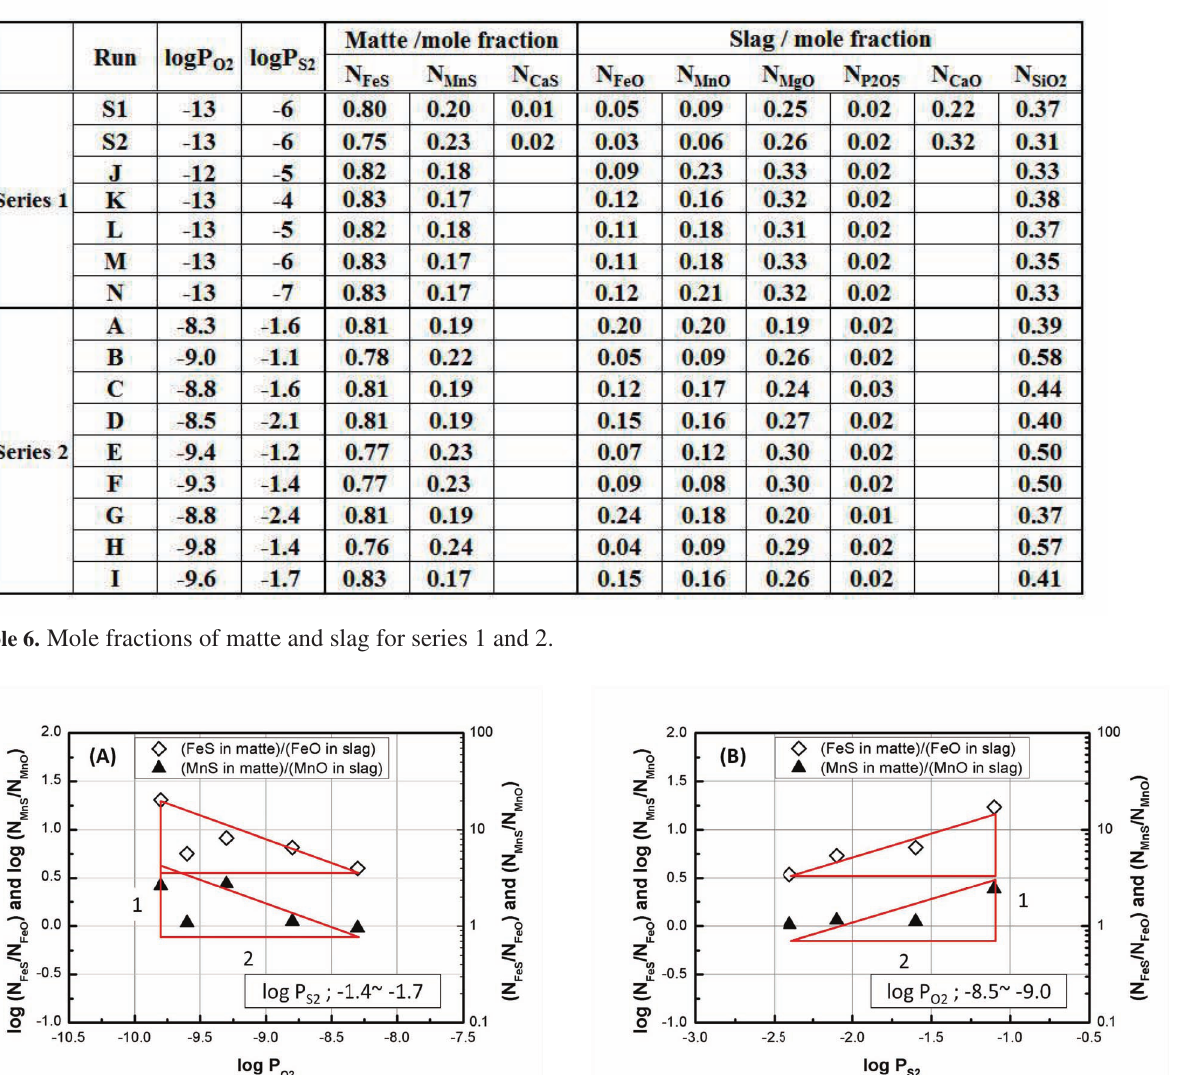
Figure 12. Relations of P O